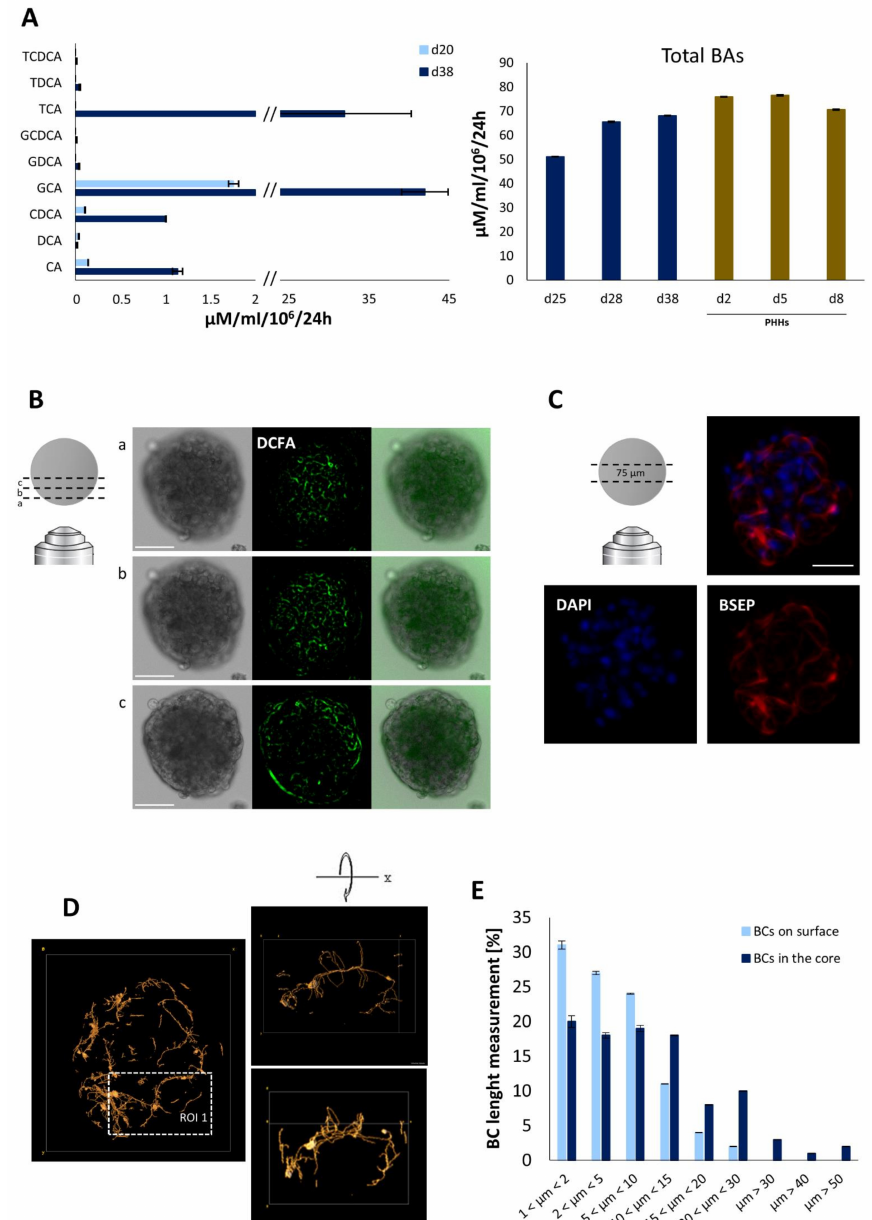
Figure 3. Bile acid secretion and bile canaliculi network analysis of iHep-Orgs. ( A ) Left panel: bile acid production and secretion by iHep-Orgs in culture supernatants at day 20 (light blue bars) and 38 (blue bars) of culture. Histograms represent mean ± SD ( n = 3). CA = cholic acid; DCA = deoxycholic acid; CDCA = chenodeoxycholic acid; GCA = glycocholic acid; GDCA = glycodeoxycholic acid; GCDCA = glycochenodeoxycholic acid; TCA = Taurocholic acid; TDCA = taurodeoxycholic Acid; TCDCA = taurochenodeoxycholic acid. Right panel: total bile acid production and secretion by iHep- Orgs (blue bars) and PHH-Orgs (brown bars) over time. Histograms represent mean ± SD ( n = 3). ( B ) Live imaging of the bile canaliculi network formed by excretion of the fluorescent probe DCFA in iHep-Org at day 38. Scale bar = 100 µ m. ( C ) Immunofluorescence staining for the apical membrane transporter BSEP in iHep-Org sections (75 µ m) at day 38. Scale bar = 75 µ m. ( D ) Left panel: 3D reconstruction of the BC network from the apical membrane transporter BSEP staining in iHep-Org sections (75 µ m) at day 38. Right panel: 3D reconstruction of a segment (ROI 1) of the BC network (rotation in x axis). ( E ) Quantification and length measurements of bile canaliculi recorded on the surface (light blue bars) and in the core (blue bars) of the iHep-Orgs after DCFA treatment and BSEP staining. Three iHep-Orgs from each of 6 independent experiments were